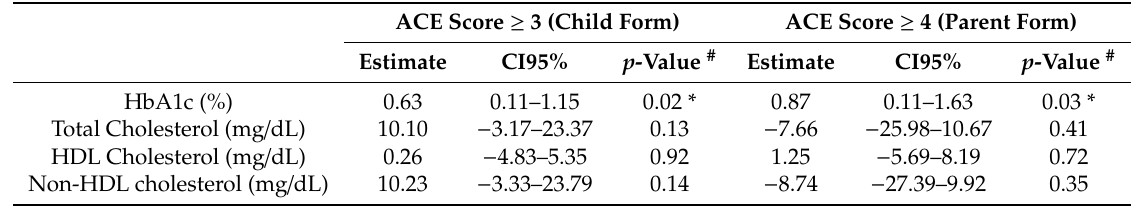
Table 2. Comparison of ACE score and laboratory parameters.